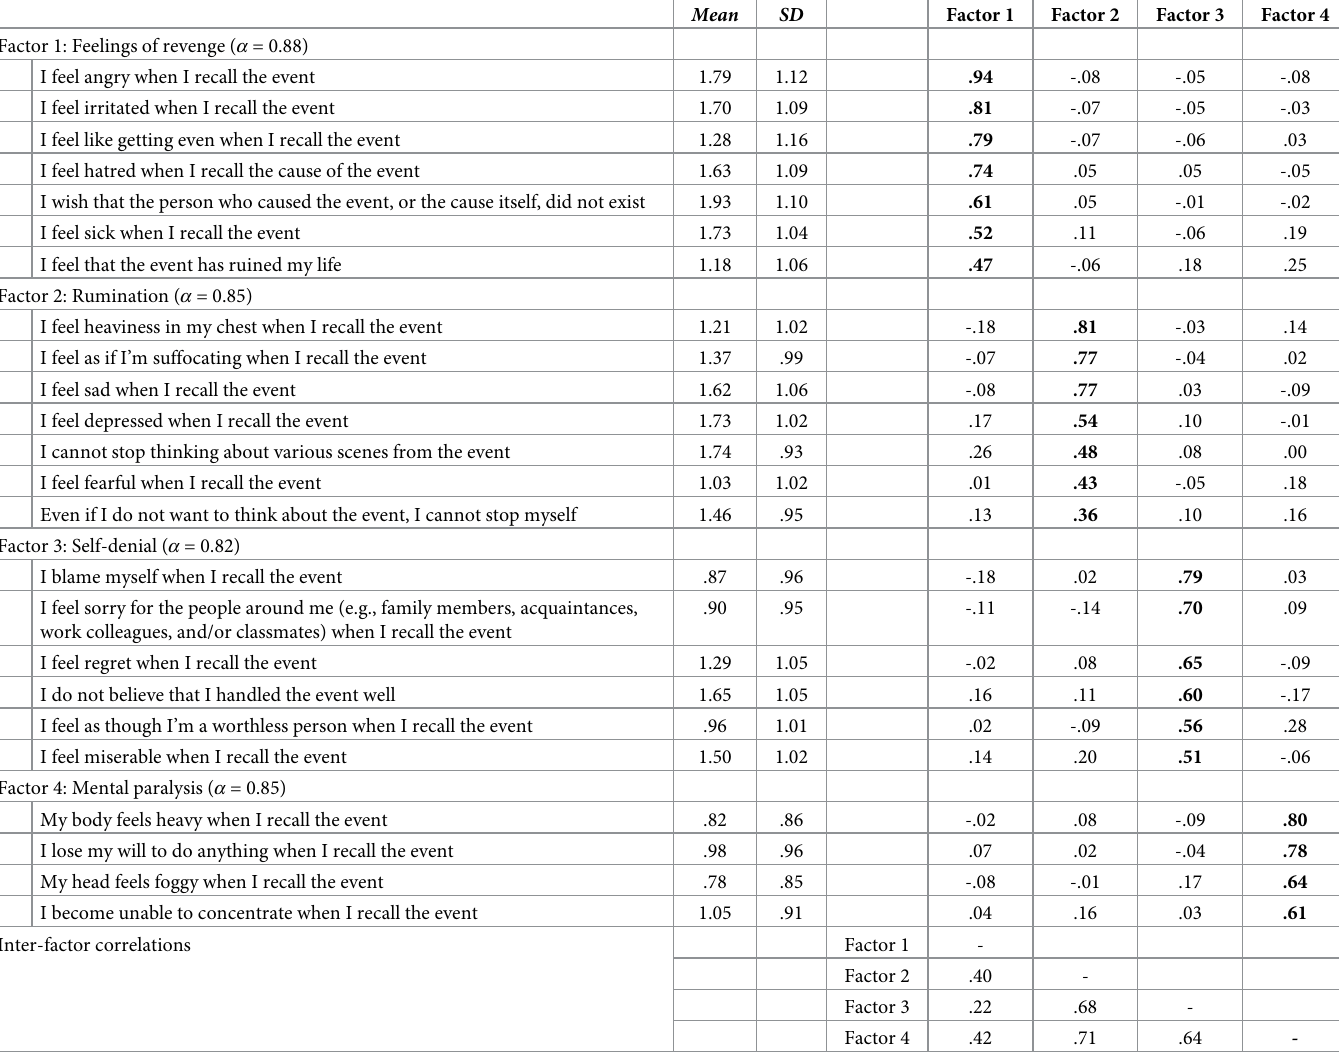
Table 3. Exploratory factor analyses of the 24-item event-related psychological distress scale ( N = 747). Mean SD Factor 1 Factor 2 Factor 3 Factor